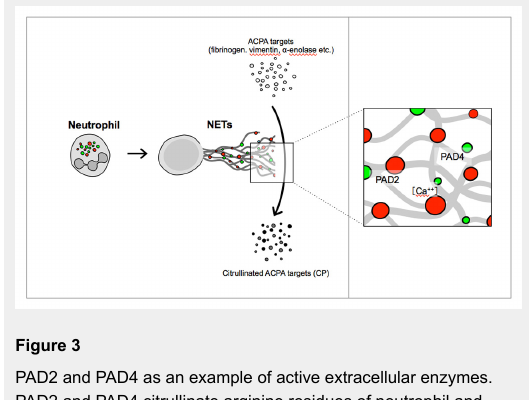
PAD2 and PAD4 as an example of active extracellular enzymes. PAD2 and PAD4 citrullinate arginine residues of neutrophil and bystander proteins to create ACPA targets. ACPA = anti-citrullinated peptide antibody; NET = neutrophil extracellular trap; PAD = peptidyl arginine